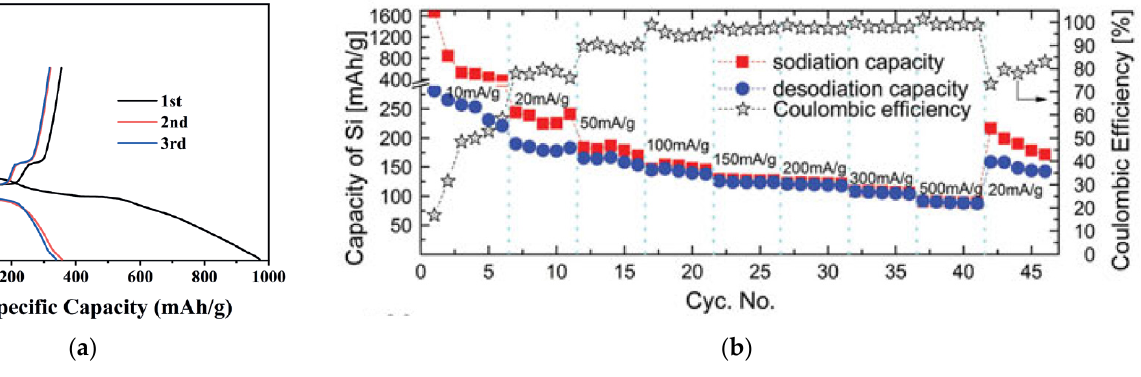
Figure 9. ( a ) Galvanostatic charge/discharge curves of Bi@N-C for first three cycles at 1 A/g. (Reprinted with permission from [170]. Copyright 2019, Wiley Online Library). ( b ) Rate capability at different current rates of Si NP electrodes. (Reprinted with permission from [178]. Copyright 2016, Wiley Online Library).